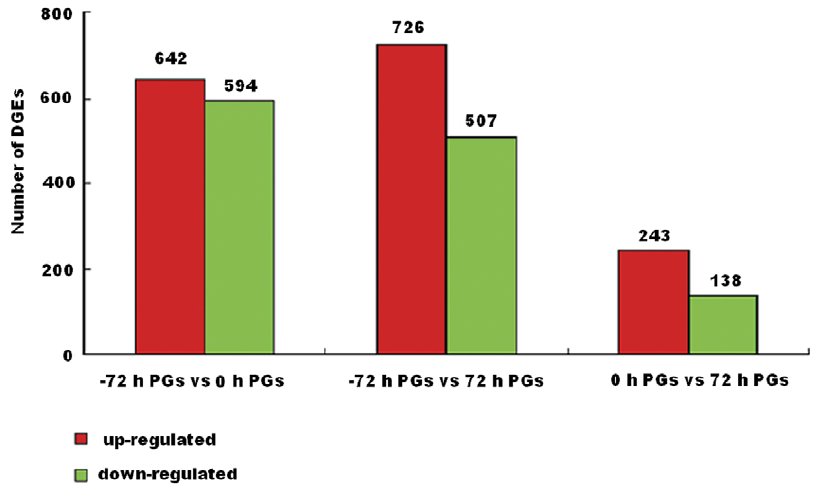
Figure 4. The numbers of differentially expressed genes at different developmental stages. Up- and down-regulated genes are summarized between 2 72 h and 0 h PGs, 2 72 h and 72 h PGs, and 0 h and 72 h PGs.